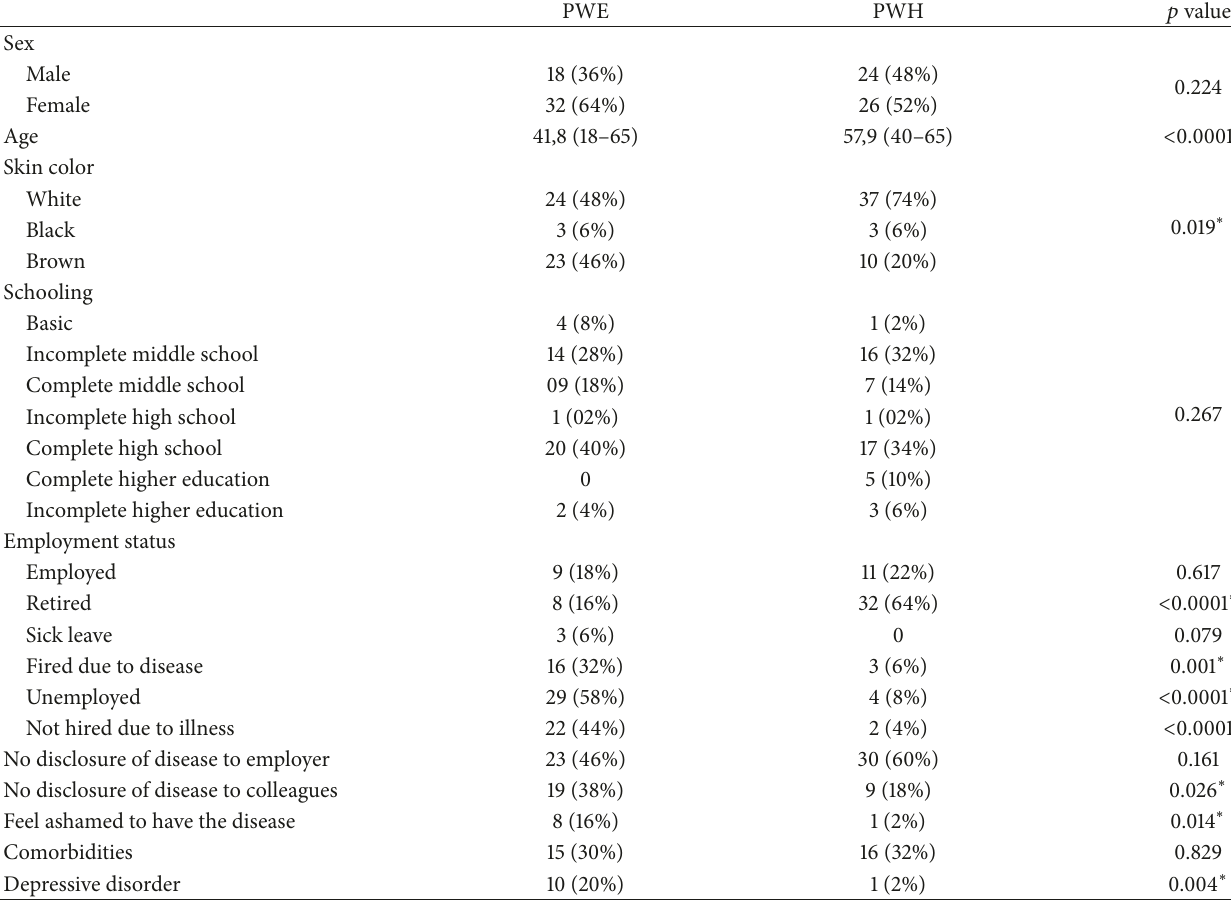
Table 1: Distributions of the comparative data between